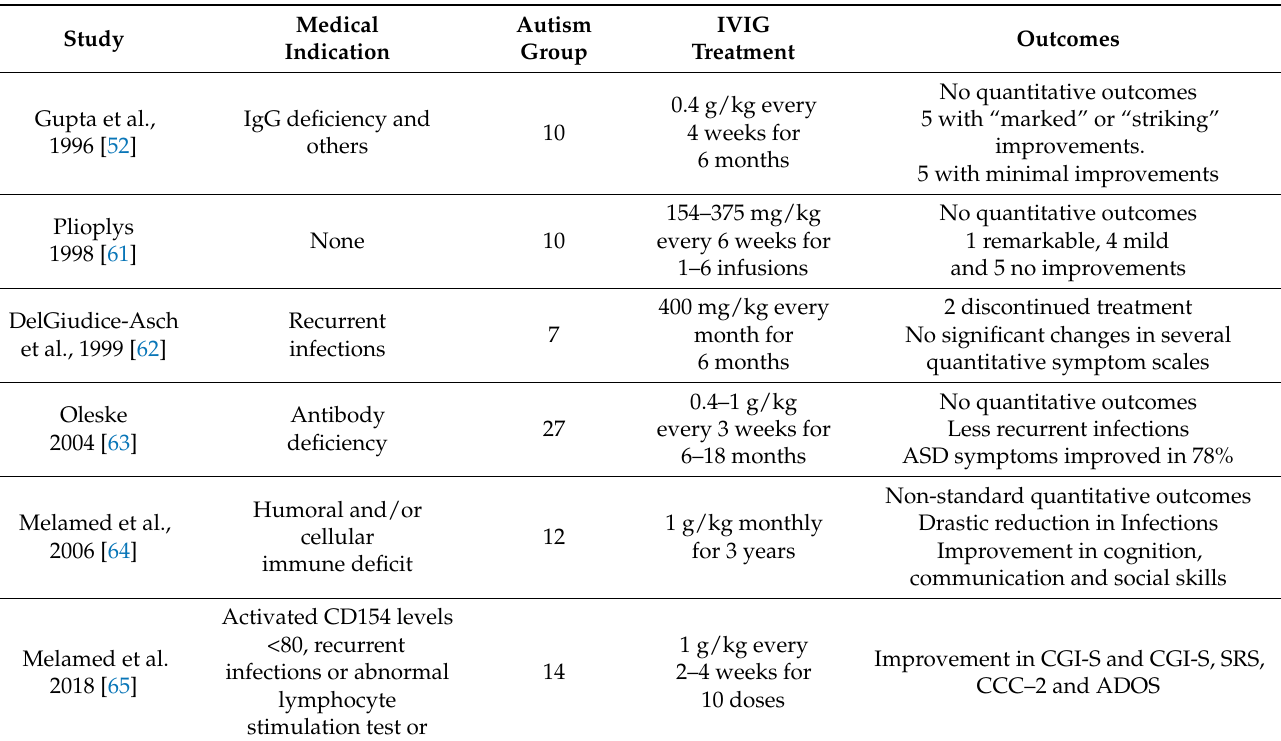
Table 4. Prospective Uncontrolled Immunoglobulin G Treatment Studies in Autism Spectrum Disorder. Specific Polysac- charide Antibody Deficiency (SPAD); Common Variable Immunodeficiency (CVID); Aberrant Behavior Checklist (ABC); Clinical Global Impression Severity (CGI-S); Clinical Global Impression Improvement (CGI-I); Social Responsiveness